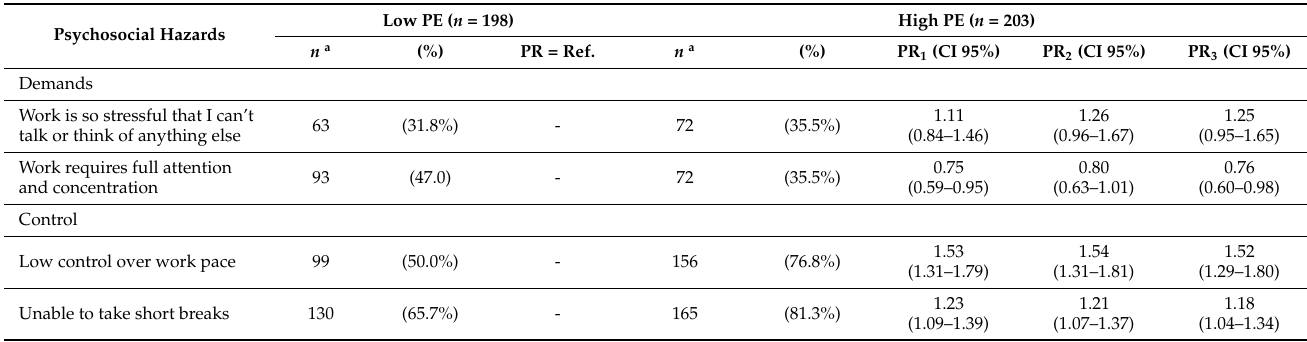
Table A2. Experiences of psychosocial hazards by low (reference group) and high precarious employment (PE). ( n = 401). Items from PREMIS survey used to construct the demand/control